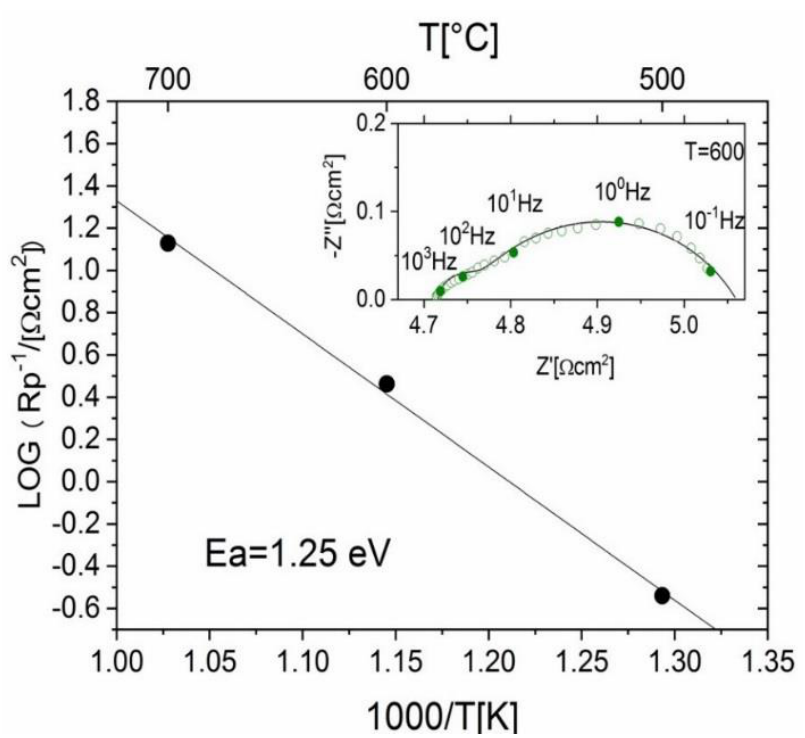
Figure 7. Arrhenius plot of inverse polarization resistance (R p ) for the BSCF31/SDC system under air, measured in a three-electrode configuration (with a RE). The inset shows the Nyquist plot of impedance at 600 °C.